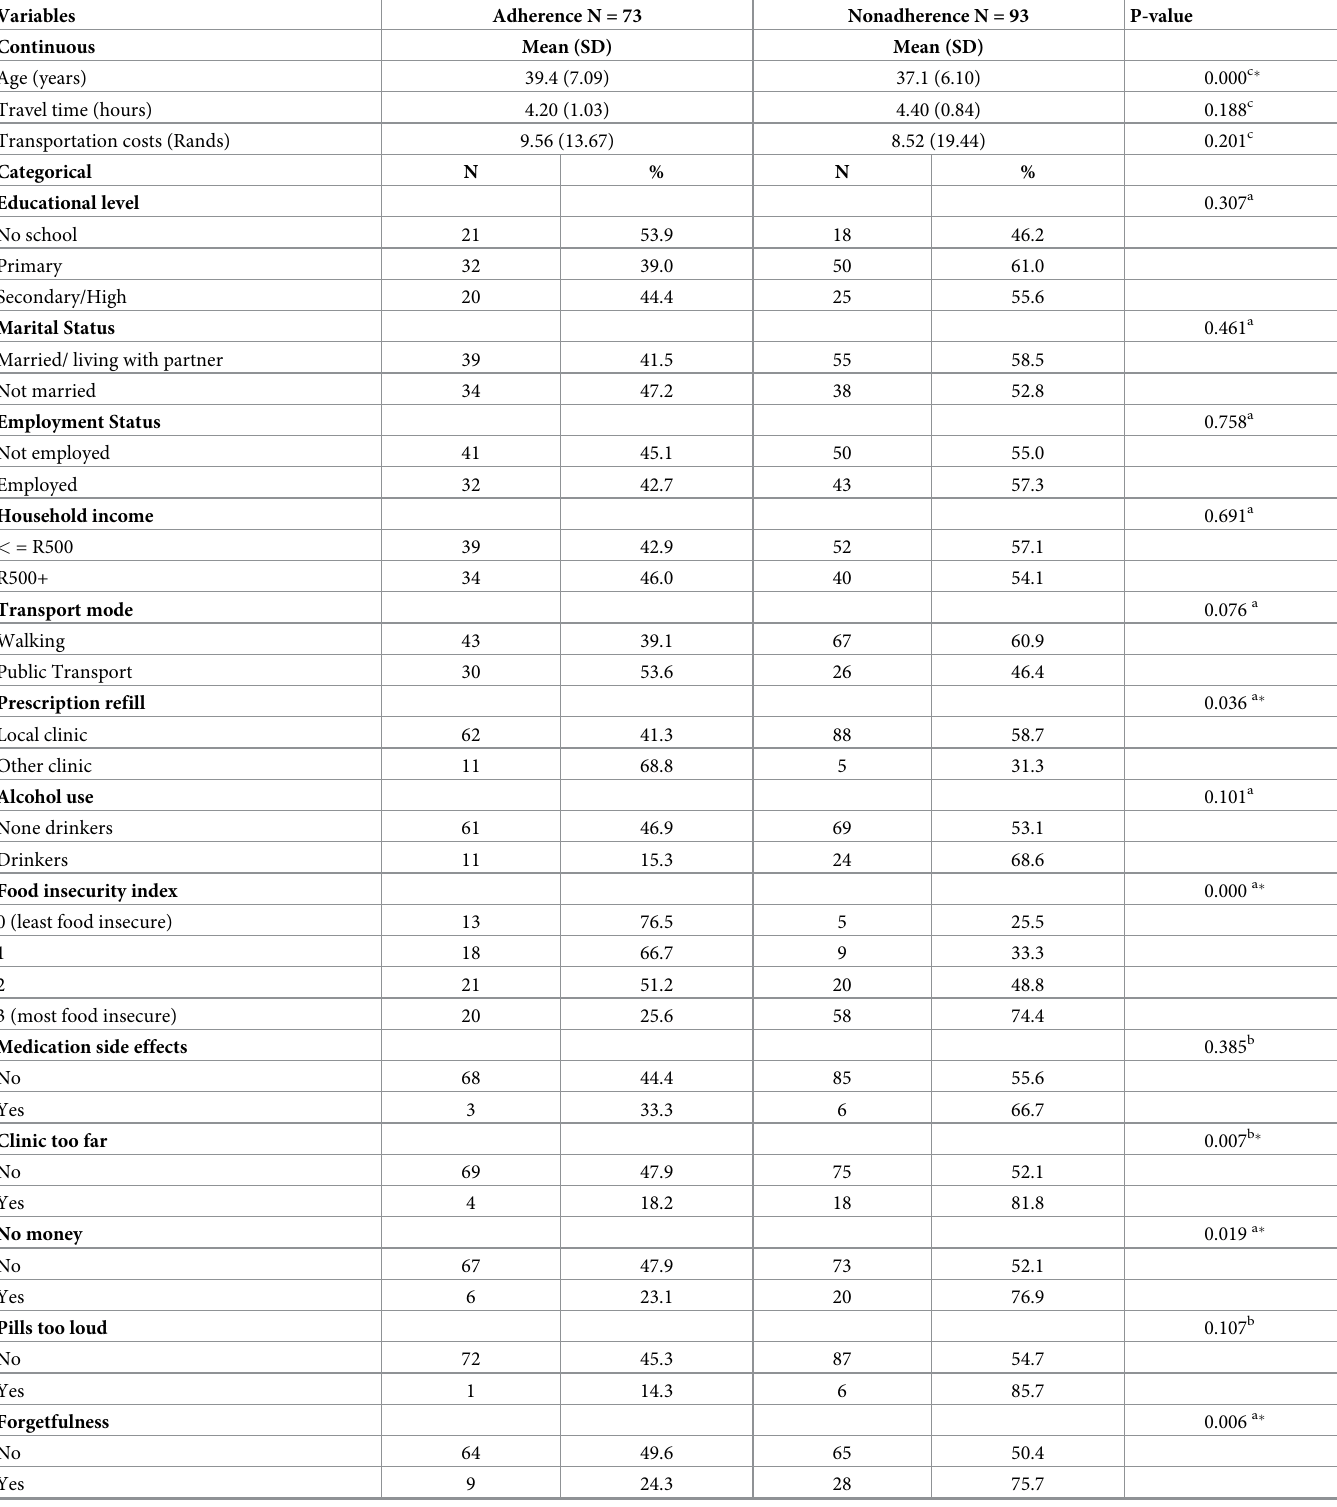
Table 2. Results of the bivariate analysis of barriers associated with nonadherence to ART among WLHIV in rural communities of